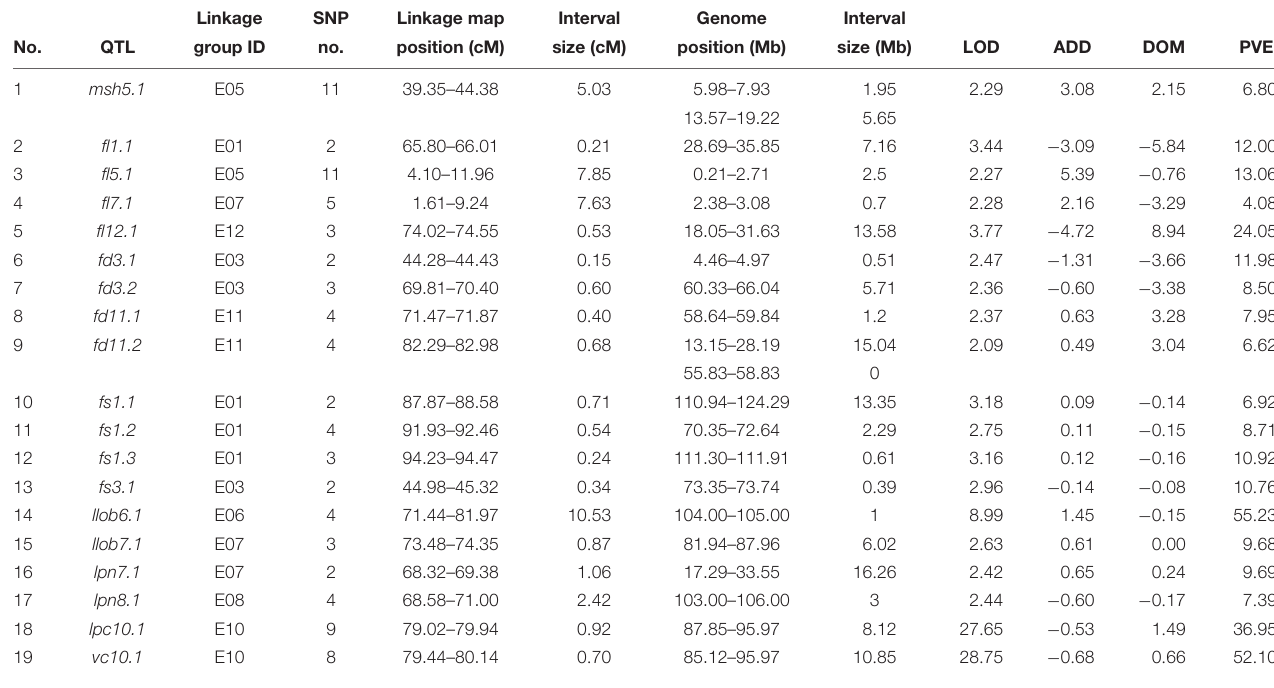
TABLE 3 | Detailed information on QTLs detected for the eight traits in the interspecific F 2